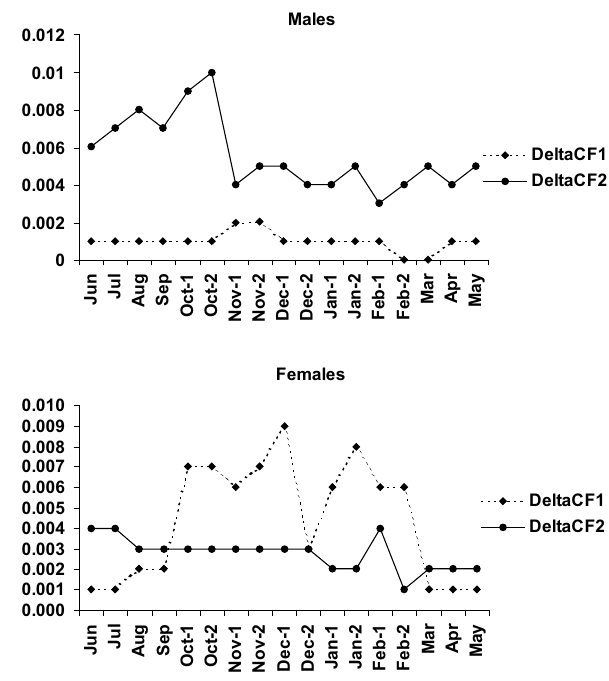
Fig. 4. Monthly variation of the ∆ CF1 and ∆ CF2 values in males and females of Eigenmannia trilineata